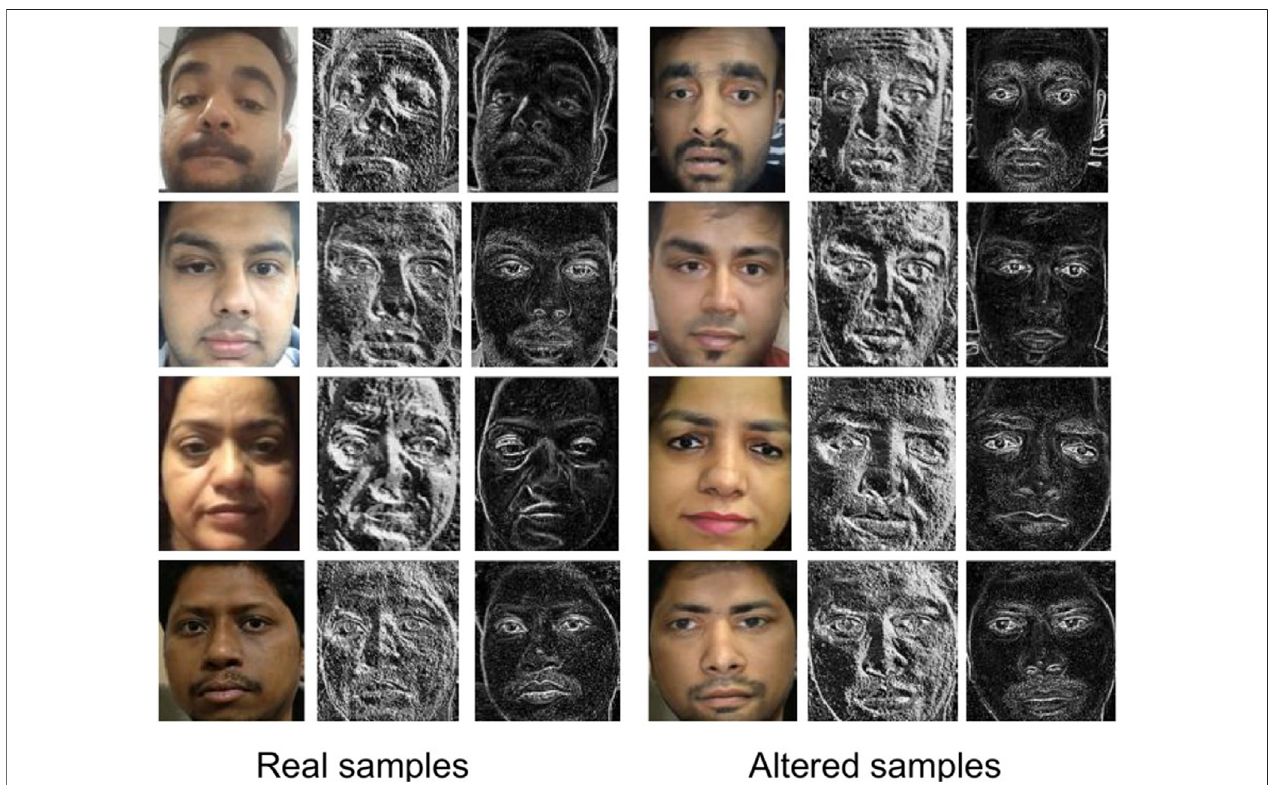
FIGURE 3 | Illustrating the features obtained for real and altered samples from Snapchat database. In both real and altered samples, fi rst column is the input images, second column is the LBP features, and last column is proposed feature images,